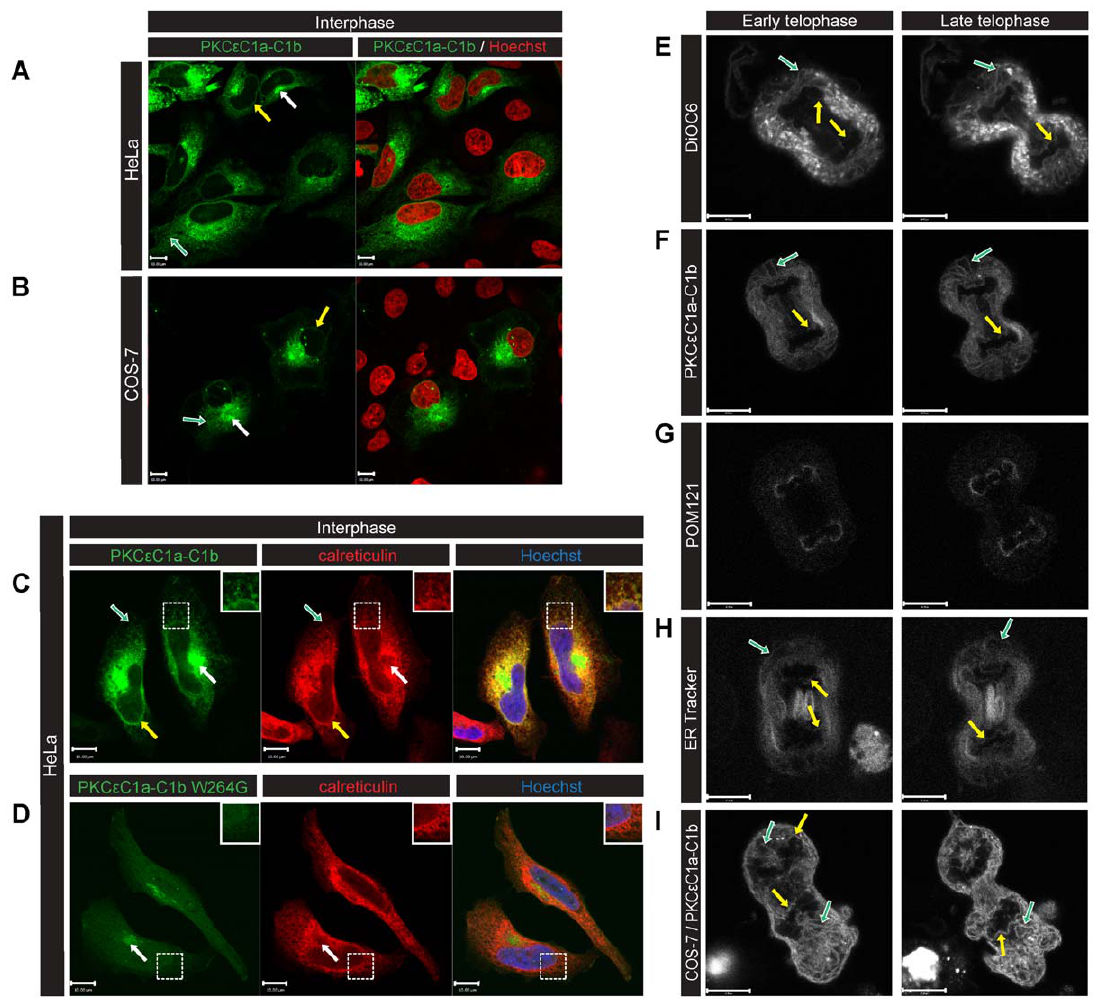
Figure 1. Diacylglycerol localises to the NE, Golgi and ER in mammalian cells. HeLa (A) and COS-7 (B) cells were transfected with EGFP- PKC e C1aC1b (DAG probe-green), fixed and imaged by confocal microscopy. DAG was localised at the NE (yellow arrows), ER (green arrow) and Golgi (white arrows). (C–D) Calreticulin (ER marker) was detected by indirect immunofluorescence (red). Apart from a minor detection of the Golgi, the signal at the ER and NE (insets) was absent in cells transfected with the DAG non-binding mutant (C1b W264G) (D). HeLa (E-H) and COS-7 (I) cells were followed through mitosis by live confocal microscopy. EGFP-PKC e C1aC1b in HeLa (F) and COS-7 (I) presented similar distributions as DiOC 6 (E), GFP- POM121 (G), and ER tracker (H). ER tubules (green arrows) and NE reformation (yellow arrows) were observed. To label chromatin, cells were incubated with Hoechst 333432 or transfected with mCherry-H2B. Scale bars: 10 m m.